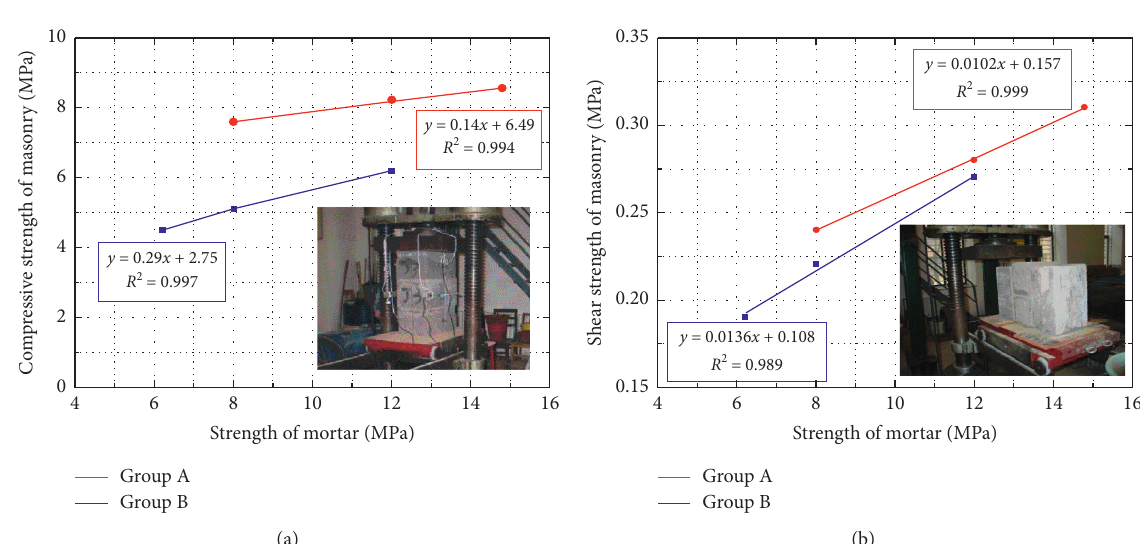
Figure 12: Stress-strain curves. (a) Group A; (b) group B.